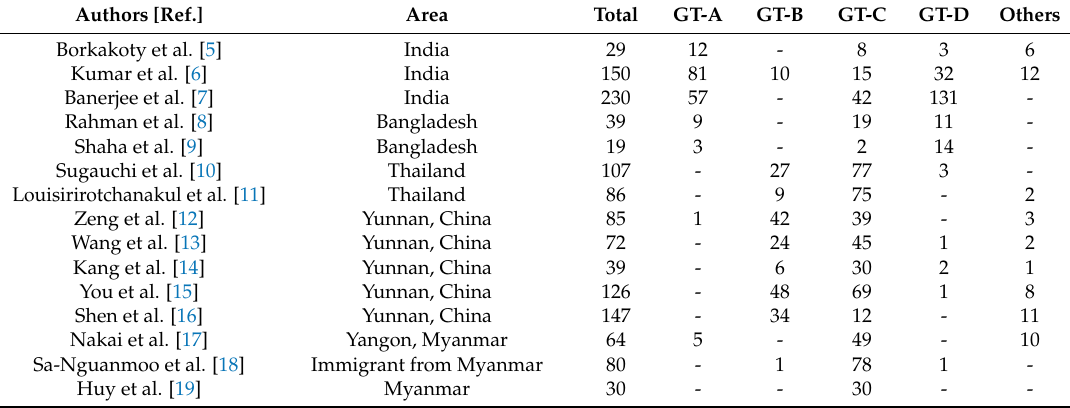
Table 1. Number of patients with various HBV genotypes (GTs) in Myanmar and neighboring countries. Authors [Ref.]